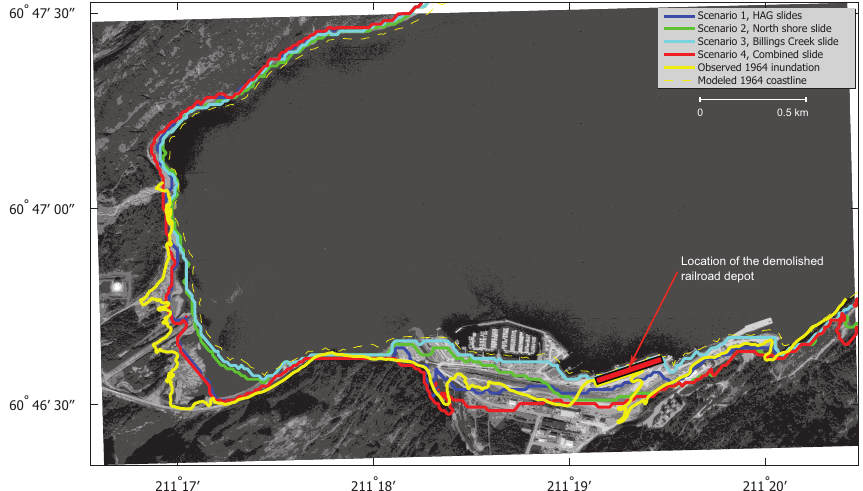
Fig. 10. Maximum computed runup by landslide-generated tsunami waves in Passage Canal during the 1964 event. The yellow line represents the observed inundation after the 1964 tsunami. The modeled MLLW shoreline before the earthquake is shown by a dashed yellow